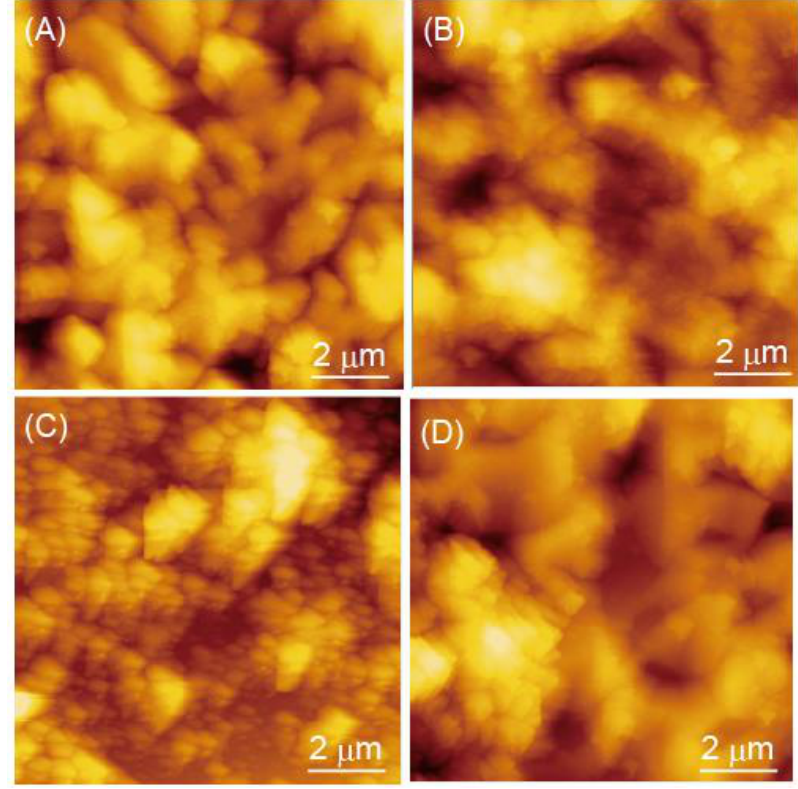
Figure 5. AFM images of dried ( A ) (PEI/TEMPO-PAA) 5 , ( B ) (PAH/TEMPO-PAA) 5 , ( C ) (PA- MAM/TEMPO-PAA) 5 , and ( D ) (PDDA/TEMPO-PAA) 5 films. TEMPO-PAA) 5 , and ( D ) (PDDA/TEMPO-PAA) 5